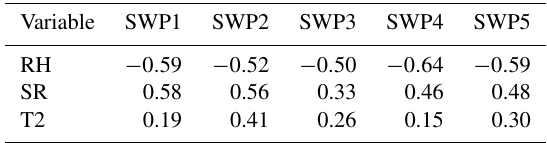
Table 2. Correlation coefficients of RH, SR and T2 with EOF1 time series under each